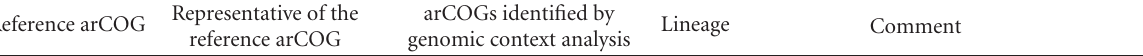
Table 1: Components of Ubl-related pathways in archaea predicted in this paper a